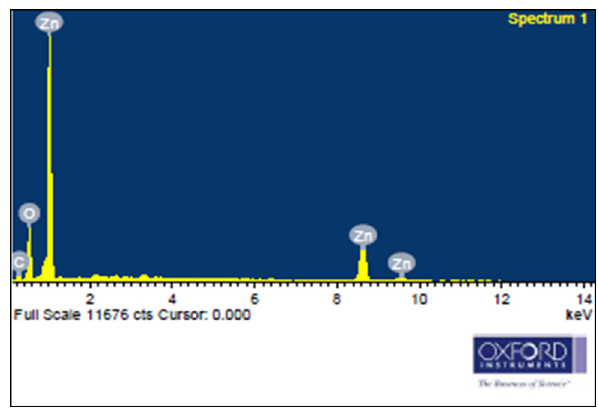
Figure 6: Elemental composition of phyto - fabricated ZnO NPs from S. acuta .